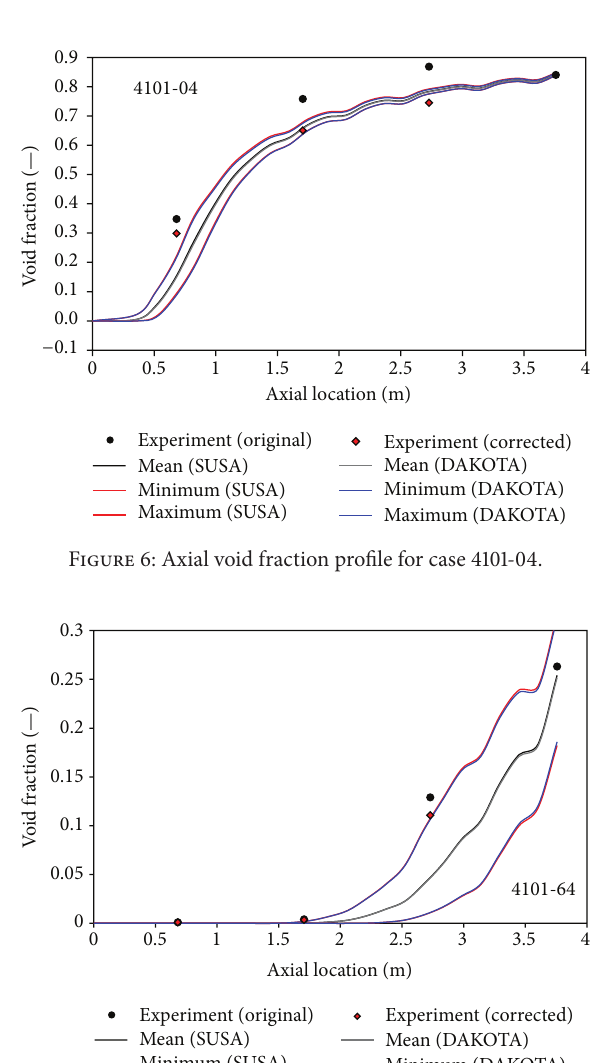
Figure 5: Relative outlet void fraction and uncertainty band for TRACE-SUSA and TRACE-DAKOTA.